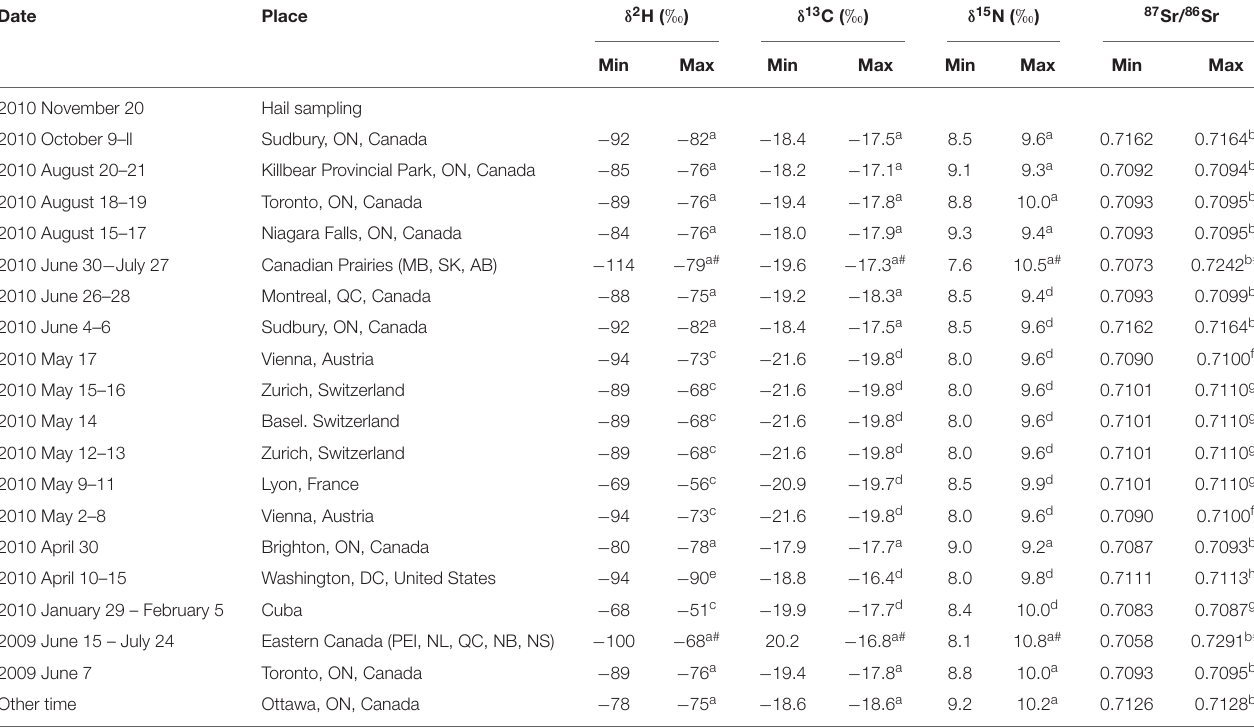
TABLE 1 | Travel history of the volunteer and the isotope ranges for each location and region.